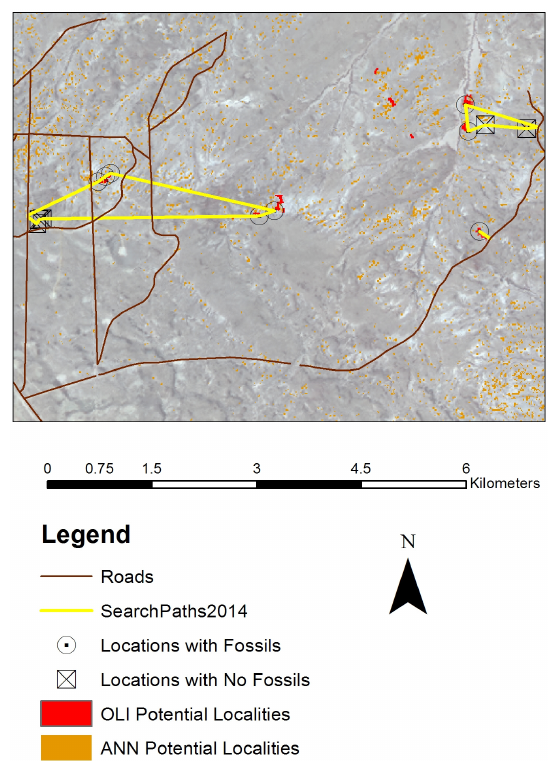
Figure 4. Landsat 8 OLI image of the 2014 search area southeast of Dugout Draw showing image objects from OLI-based and ANN-based models and results of field searches of selected high priority sites.